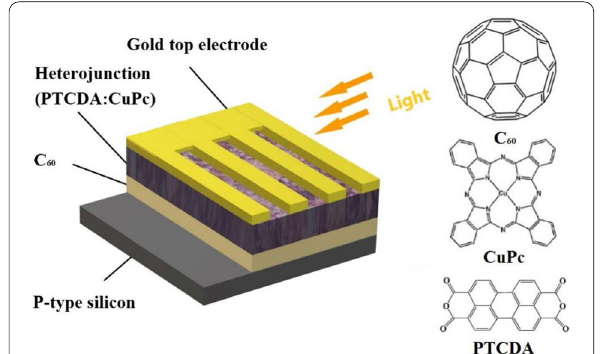
Fig. 1 The schematic structure of devices based on hybrid planar-bulk heterojunction. The insets are molecular structures of PTCDA, CuPc and C